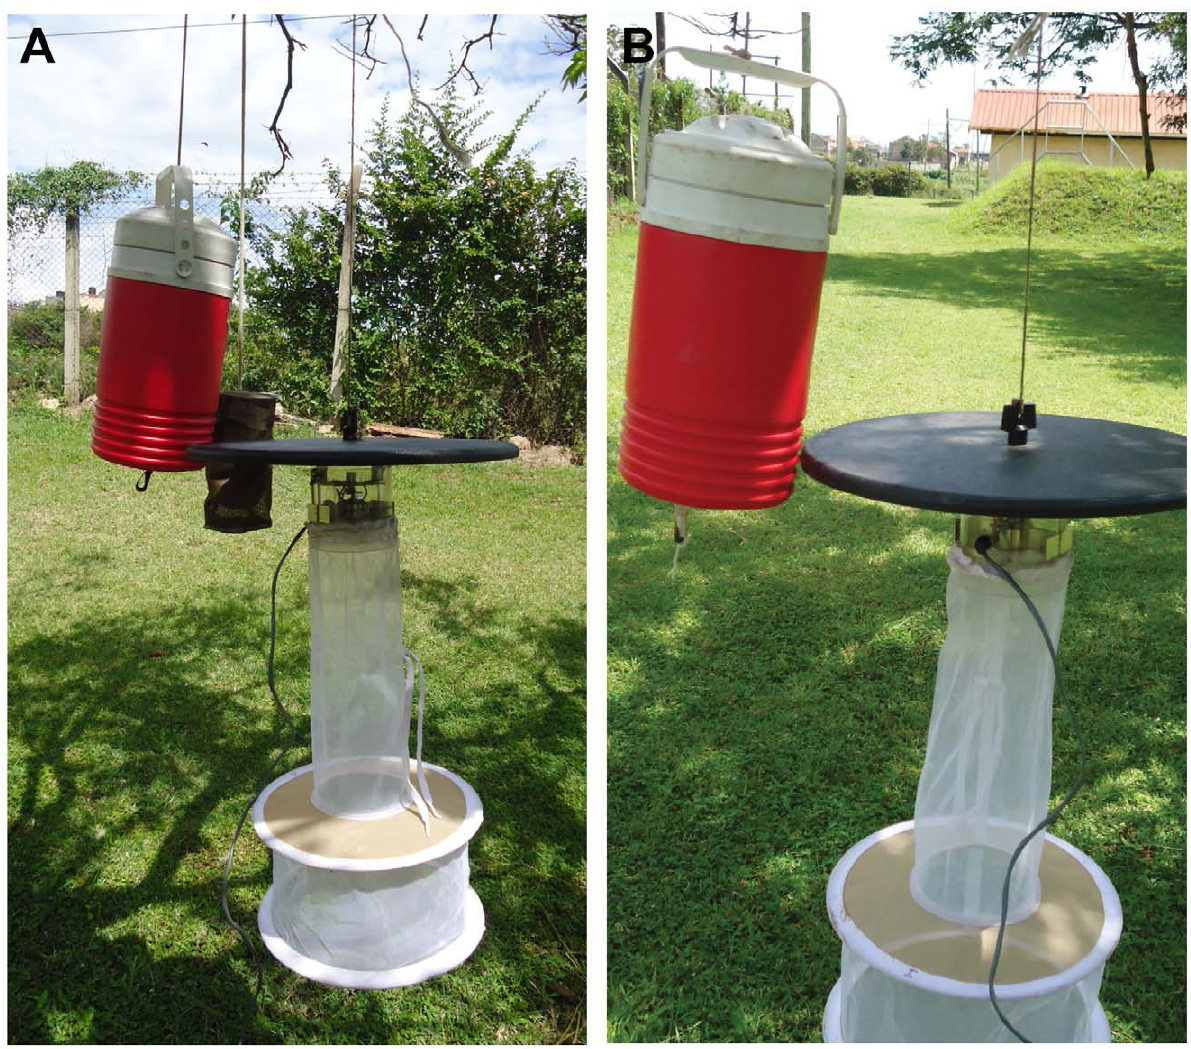
Figure 2. Trap design using CDC trap without a light bulb for field evaluation. (A) crude animal skin odors: arrangement of canister and CO 2 released at the bottom of the Igloo container all placed close to the fan of the trap; (B) synthetic compounds released from a 0.5 ml tube placed under the Igloo close to the air flow of CO 2